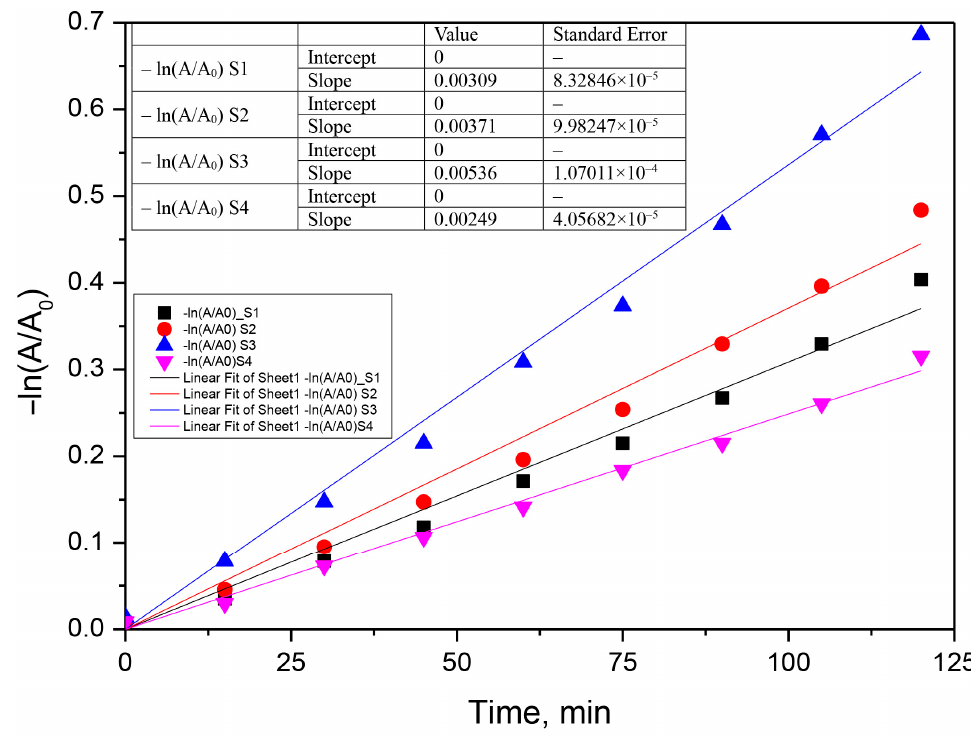
Figure 10. Fits of the pseudo-first-order kinetic model for the photocatalytic chlortetracycline degra- dation using the S1–S4 photocatalyst (0.05 g · L − 1 , chlortetracycline concentration 0.025 g · L − 1 ).